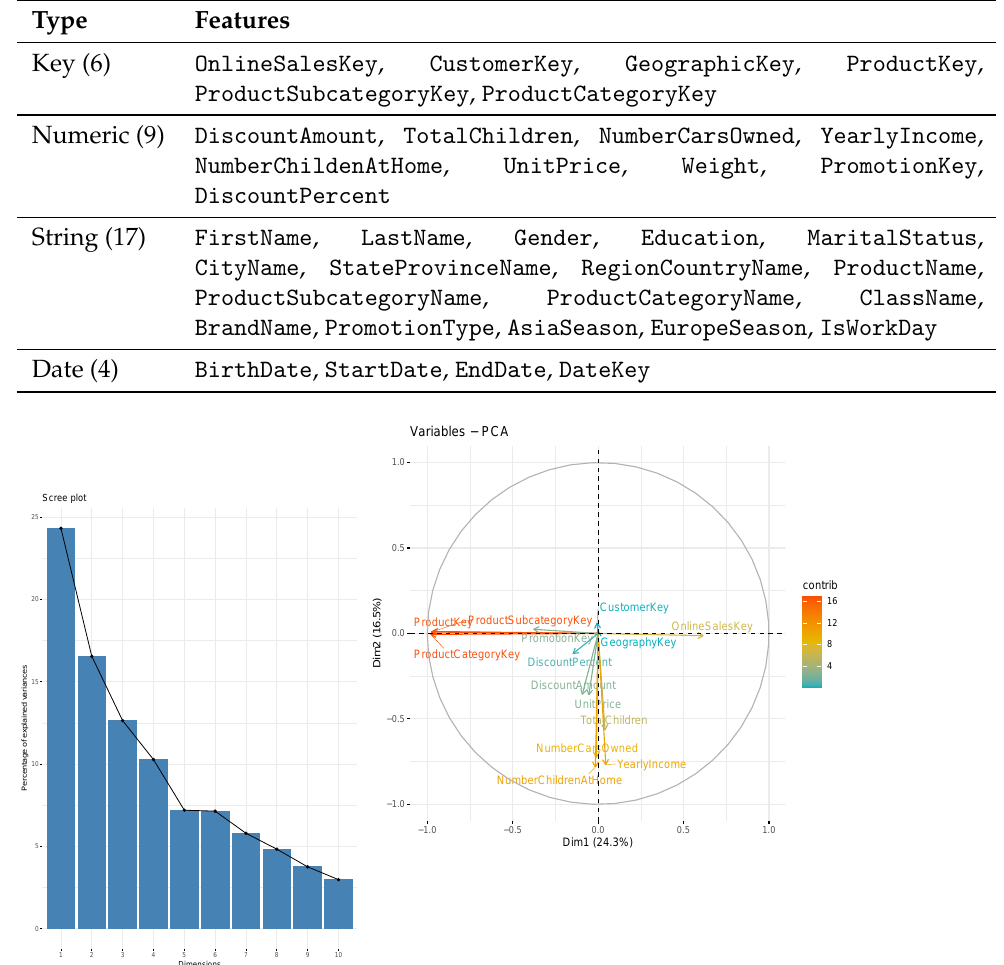
Table 1. A summary of the features in the dataset.